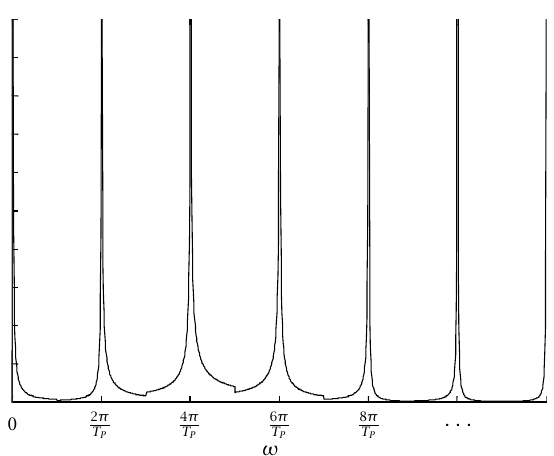
Figure 5: Model pseudo-periodic power